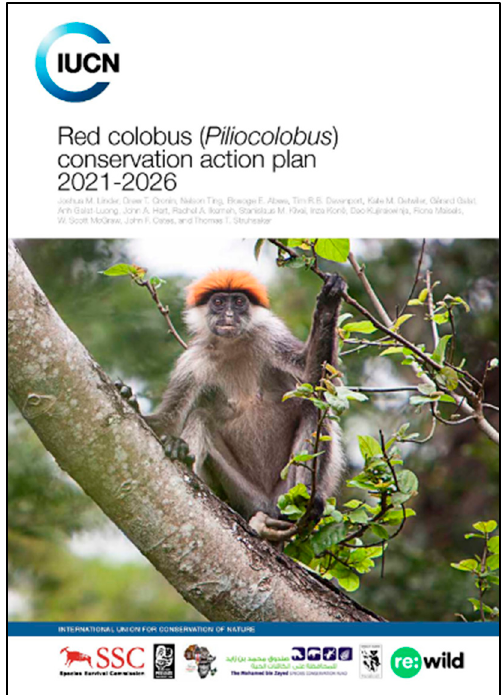
Figure 6. The cover of the Red Colobus action plan [18].